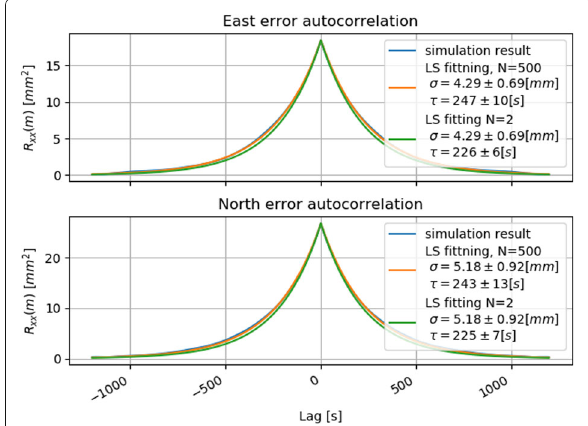
Fig. 12 Autocorrelation of the localization error in Loc1 , computed on the basis of: simulation, Eq. (42) with N = 500, and Eq. (34). σ and τ parameters are estimated with 95% confidence intervals